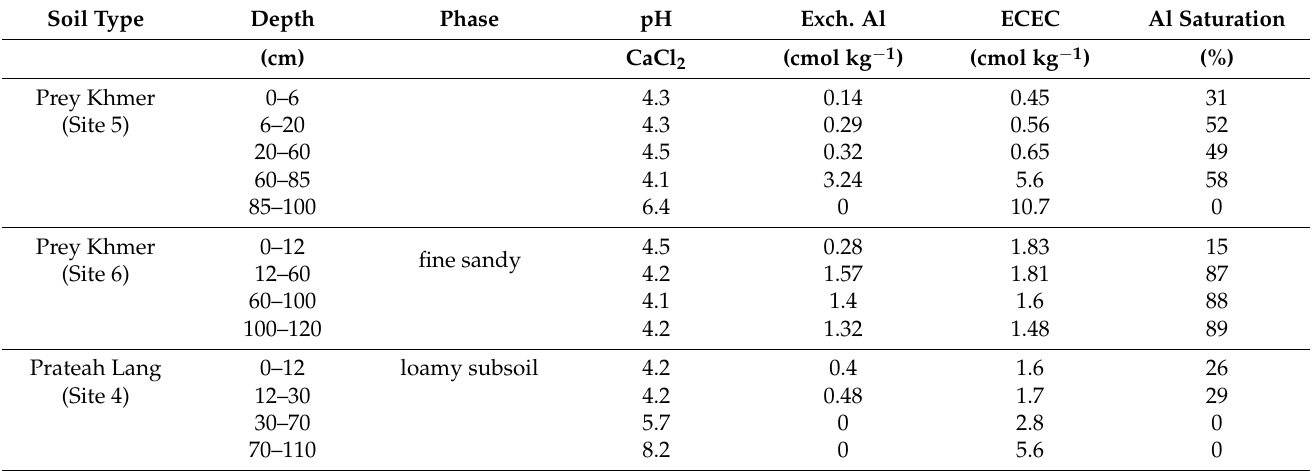
Table 6. Soil pH and exchangeable Al in three sands of Tramkak District, Takeo,